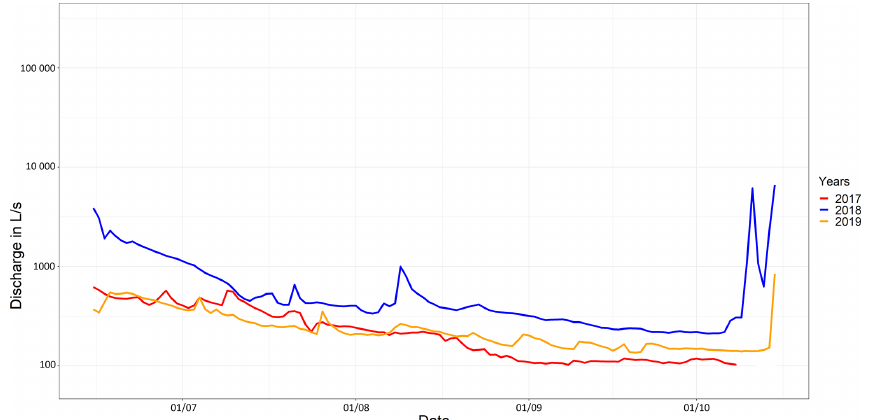
Figure 2. Gardon de Sainte-Croix hydrographs during the low-flow period between 2017 and 2019. The end of the low-flow period is different for each year and depends on the dates of the first important rainfall events. These hydrological data have been measured at the outlet of the catchment (Le Martinet hydrometric station) by the UMR ESPACE 7300 CNRS (Martin et al.,